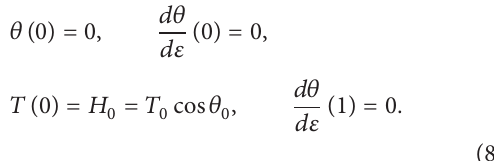
Table 2: Different loads on the pipeline in the first case.